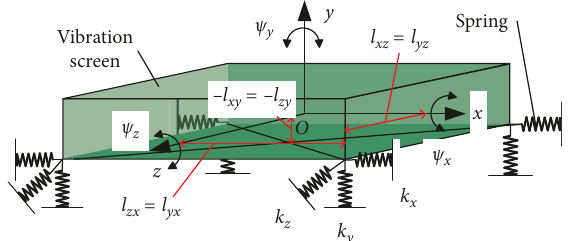
Figure 2: Sketch map of 6 degrees of freedom vibration